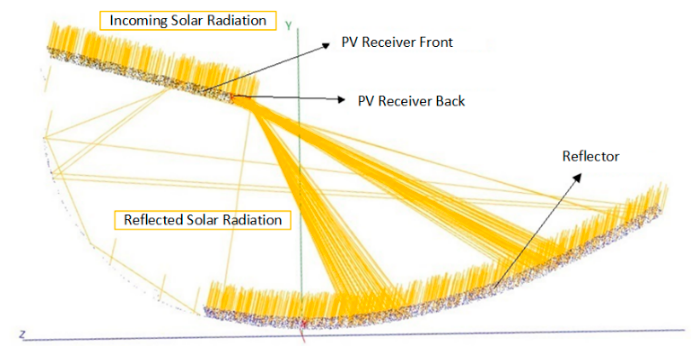
Figure 1. 3-D representation of the optical collector model in SolTrace.